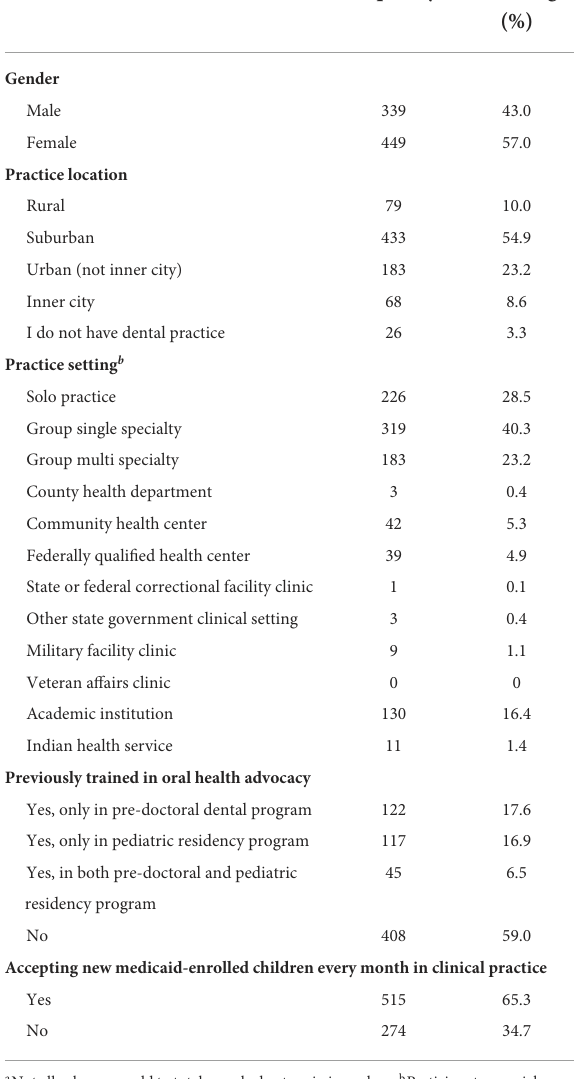
TABLE 1 General characteristics of responding pediatric dentists ( n =